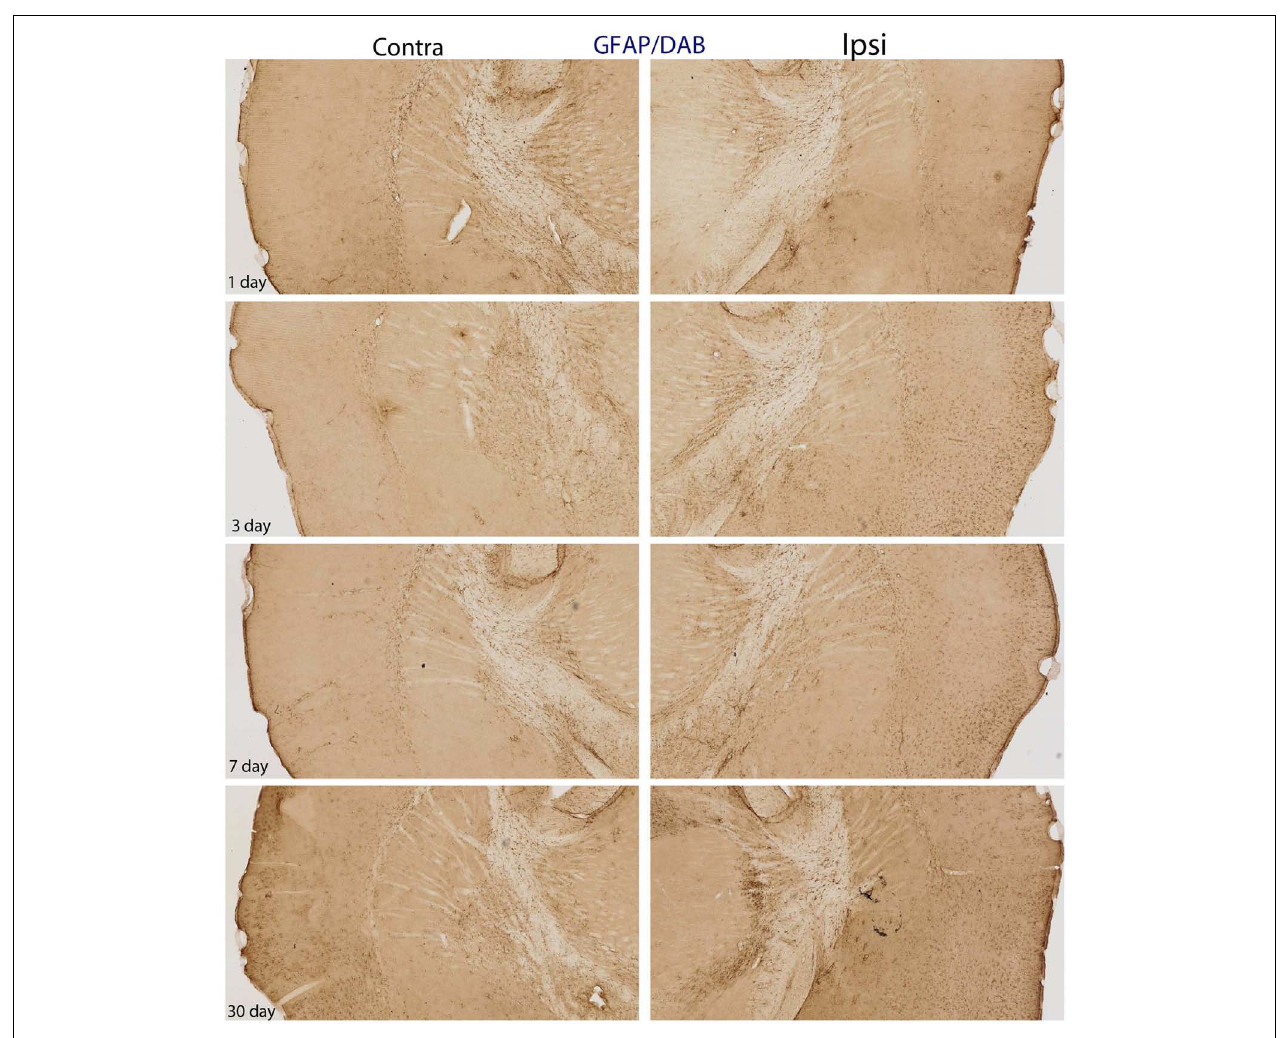
to appreciate the coordinates of the tissue, as well as the relative staining in the ipsi and contra lateral hemispheres at lower